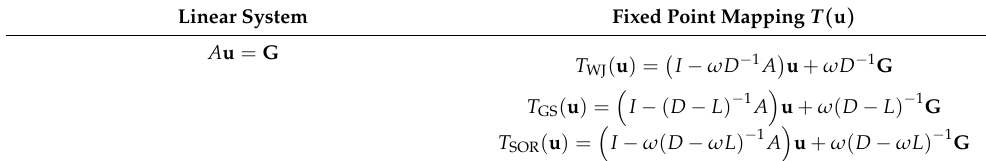
Table 5. The alternative method of rearranging the linear systems (25) into the form u = T ( u ) . Linear System Fixed Point Mapping T ( u